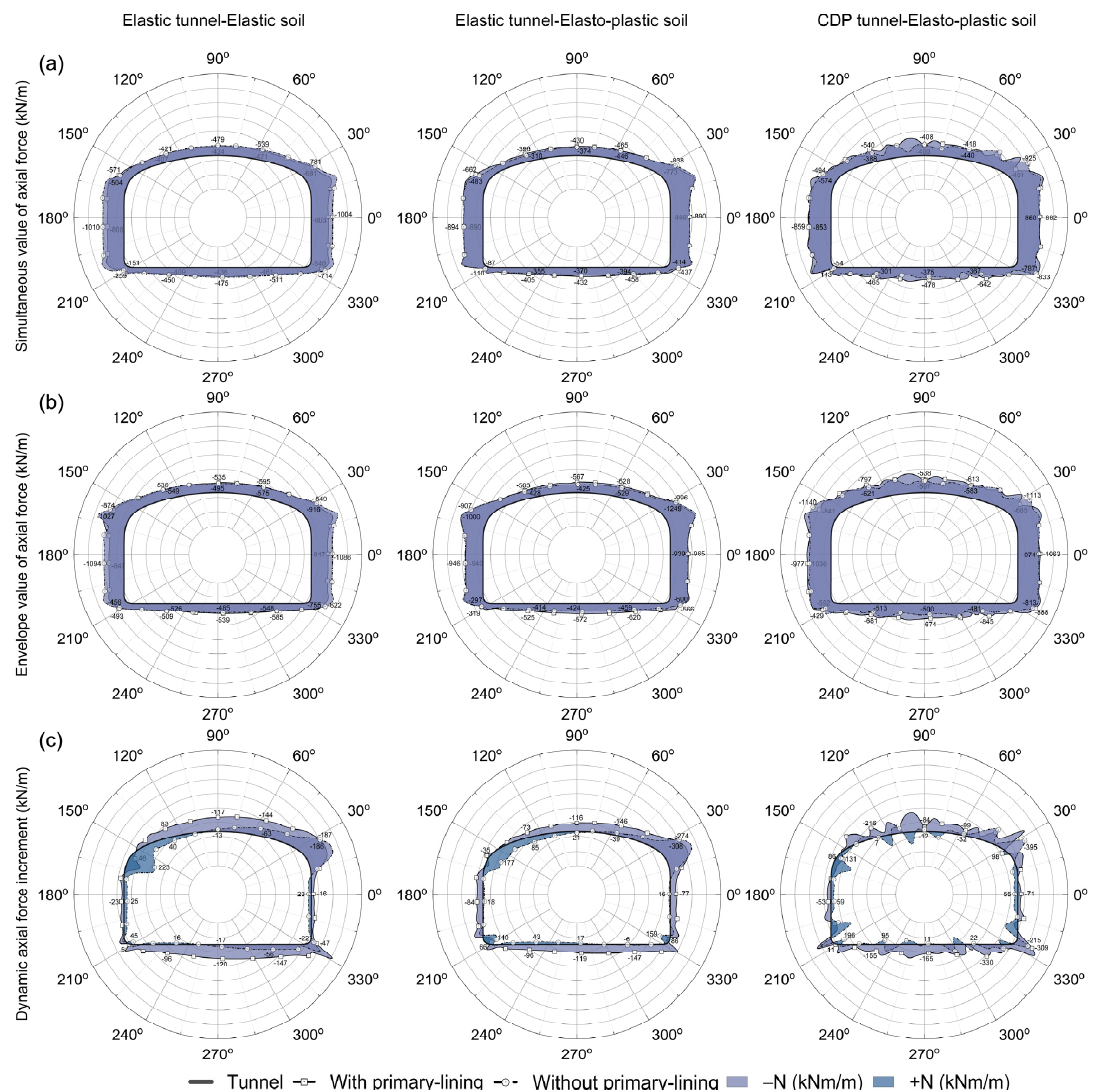
Figure 20. Axial force distributions computed along the perimeter of the tunnel for EQ1: ( a ) simultaneous value of axial force, ( b ) envelope value of axial force, ( c ) dynamic axial force increment of the maximum positive (+X) shear deformation.